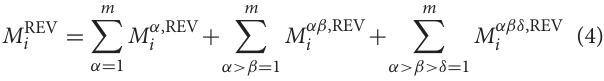
FIGURE 1 | A representative elementary volume (REV) (magenta squares, length l ) in a system (white box of length L ) that is exposed to for instance a pressure difference, 1 p , a temperature difference, 1 T , and differences in chemical potentials 1µ i . A (blue) dot is used to represent the state that characterizes the REV. The set of state variables are positioned on the x -axis: The temperature, pressure and the chemical potentials, ( T , p , µ i )(x). The figure is adapted from Kjelstrup et al.